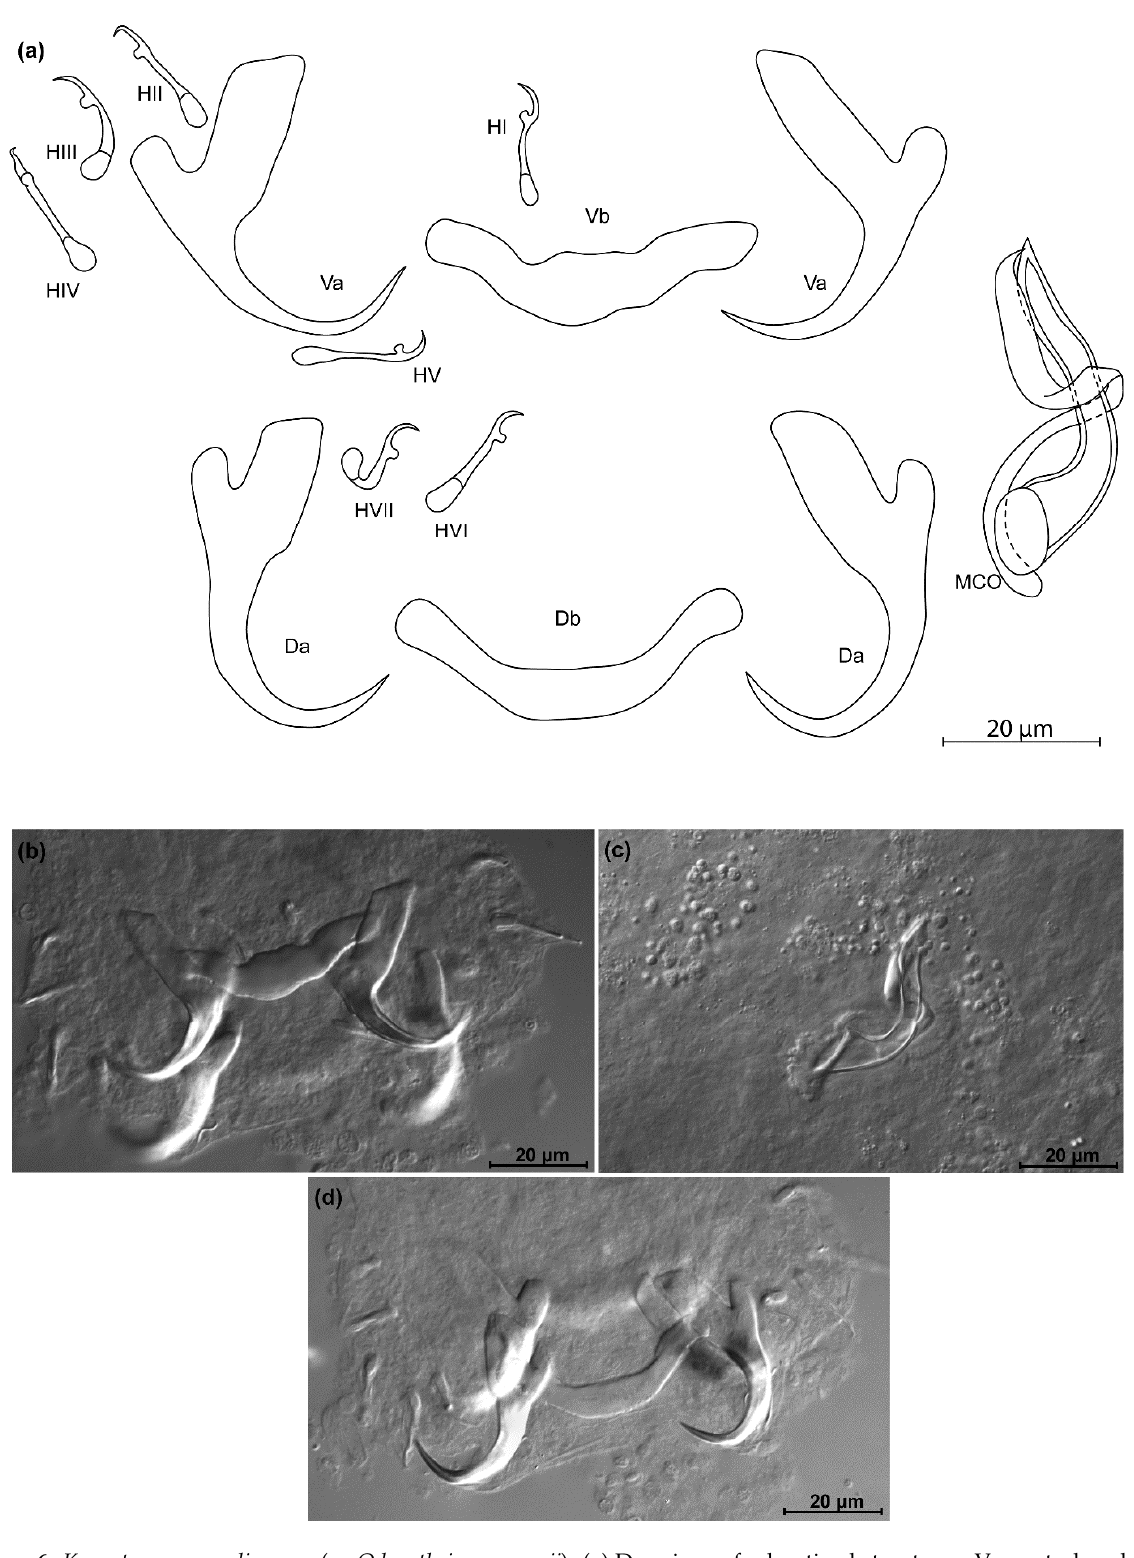
Figure 6. Kapentagyrus voreli n. sp. (ex Odaxothrissa ansorgii ). ( a ) Drawings of sclerotized structures, Va-ventral anchors. Da-dorsal anchors. Db-dorsal bar. Vb-ventral bar. H-hooks (pairs I to V—ventral; pairs VI, VII—dorsal). MCO-male copulatory organ. ( b ) Micrograph of ventral anchors and ventral bar. ( c ) Micrograph of MCO. ( d ) Micrograph of dorsal anchors and dorsal bar.